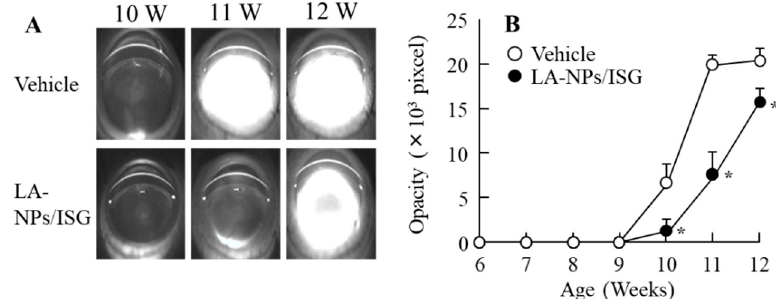
Figure 6. Lens opacification of Shumiya cataract rats with a combination of remarkable lens structure collapse and opacification (SCR-C) repetitively instilled with LA-NPs/ISG. ( A , B ) Scheimpflug slit images ( A ) and opacity levels ( B ) of SCR-C lenses repetitively instilled with LA-NPs/ISG. The repetitive instillations were performed twice per day from six weeks of age. Vehicle is solution consisting of BAC, mannitol, HPCD, and MC. n = 6. * p < 0.05, vs. Vehicle for each group. The onset of opacification in the SCR-C was delayed by the repetitive instillation of LA-NPs/ISG.